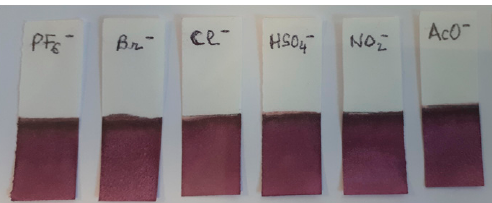
According to the calculations, only 7.2% of CH 3 CO 2 − remains free in solution vs. 26.8%